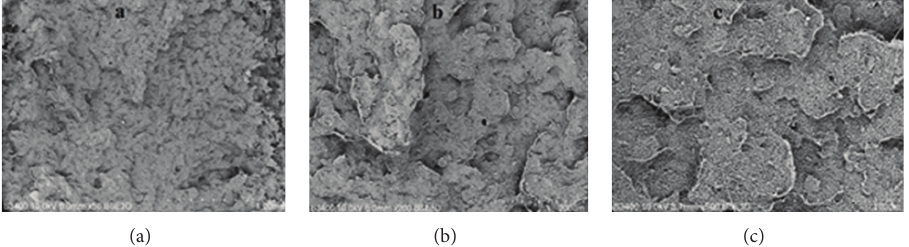
Figure 5: : SEM micrograph of the surface on 0% RH loading contents composites: (a) 50x magnification, (b) 200x magnification, and (c) 500x magnification.